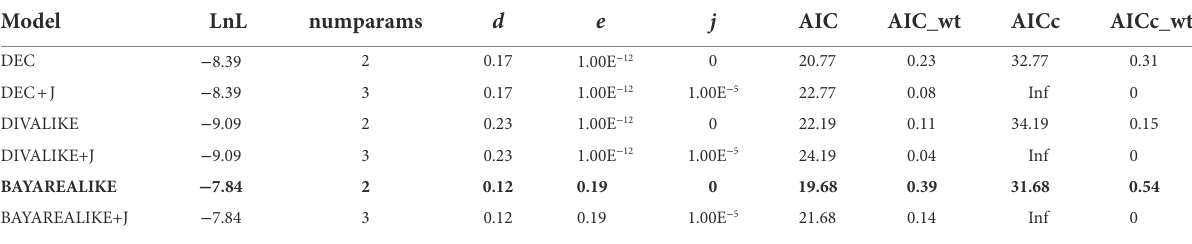
TABLE 2 Model comparison and parameters (d, dispersal; e, extinction; j, founder speciation) of ancestral area estimation of the Gentiana hexaphylla complex based on BioGeoBEARS.